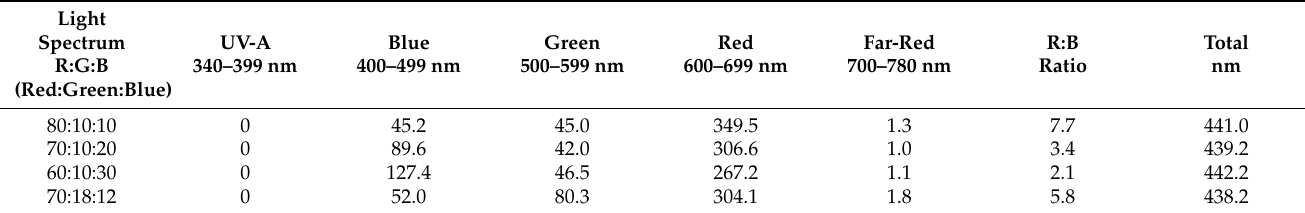
Table 1. Spectral photon flux PPF ( µ mol s − 1 ) for the 4 LED light spectra in vertical cultivation of romaine lettuce (fraction of integral photon flux ranging from 340 to 780 nm in ultraviolet, blue, green, red, and far-red). Light Spectrum R:G:B